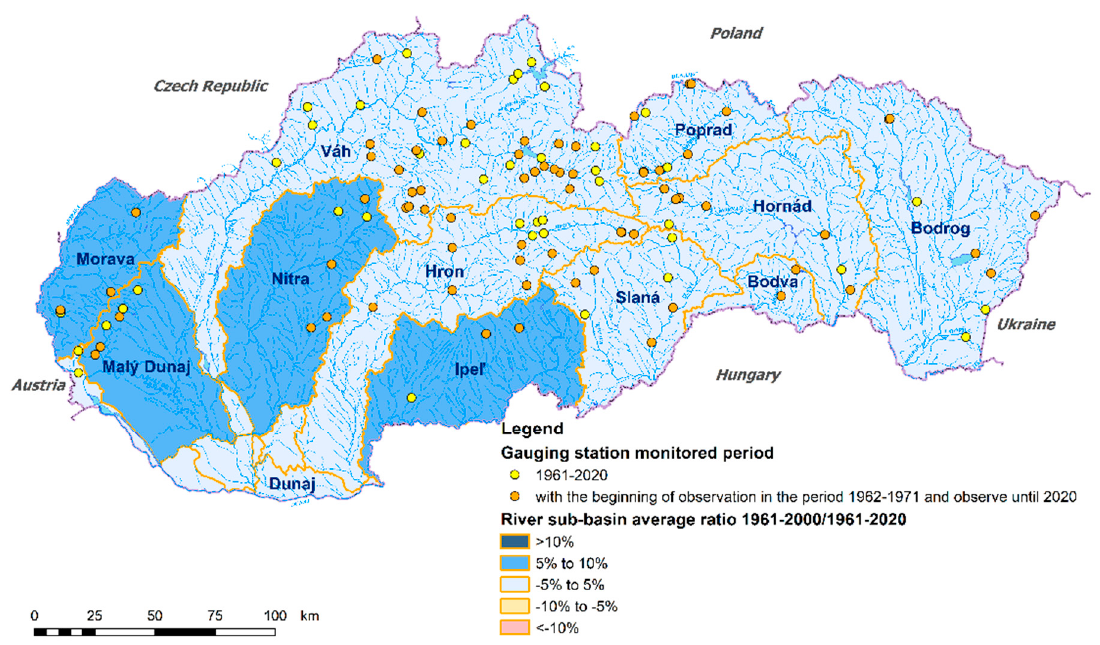
Figure 1. Selected water-gauging stations and the average deviations of long-term flows of two reference periods, 1961–2000 and 1961–2020, in river sub-basins.